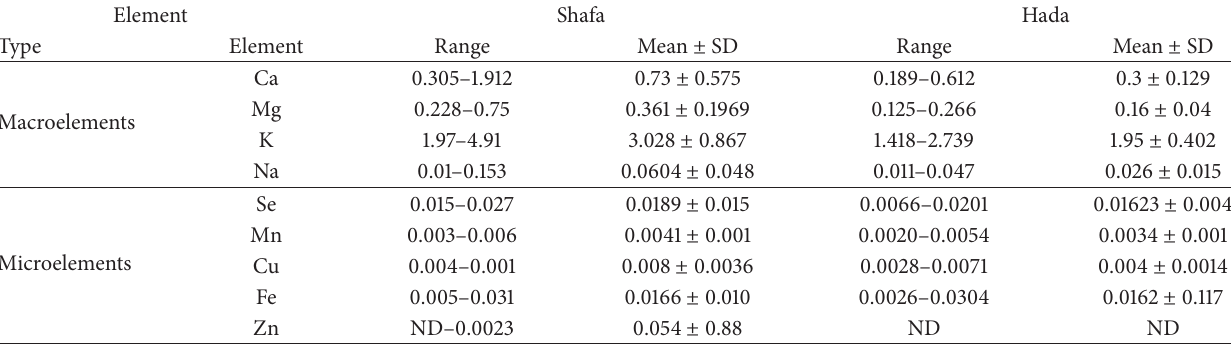
Table 3: Mean levels of macro- and microelements in Shafa and Hada rose petal samples (mg/kg). Element